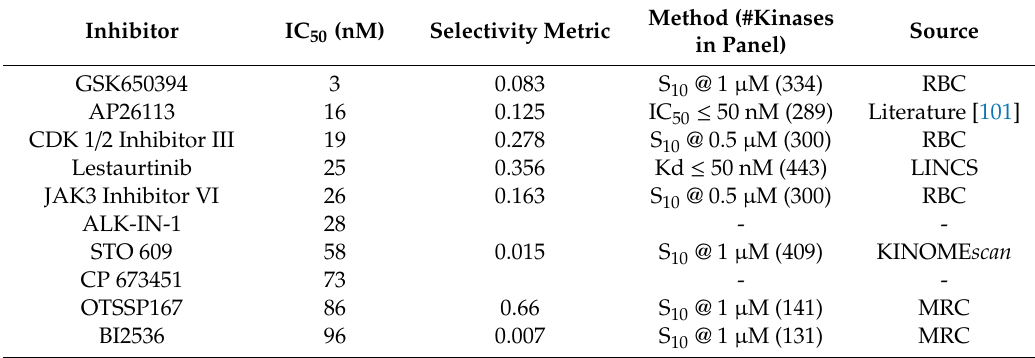
Table 2. Potent CAMKK2 inhibitors, their IC 50 values and calculated selectivity metrics. The method for determination of a given metric was calculated is shown under the method column. The number of kinases used in the calculation is shown in parentheses. The origin of the data is shown under source. Inhibitor IC 50 (nM) Selectivity